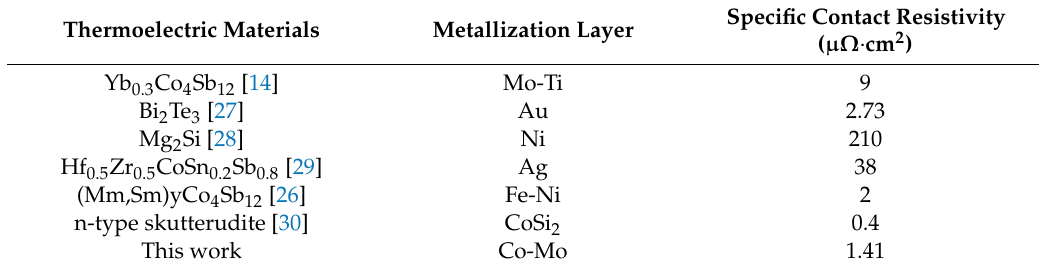
Table 2. The specific contact resistivity for various classes of thermoelectric materials. Thermoelectric